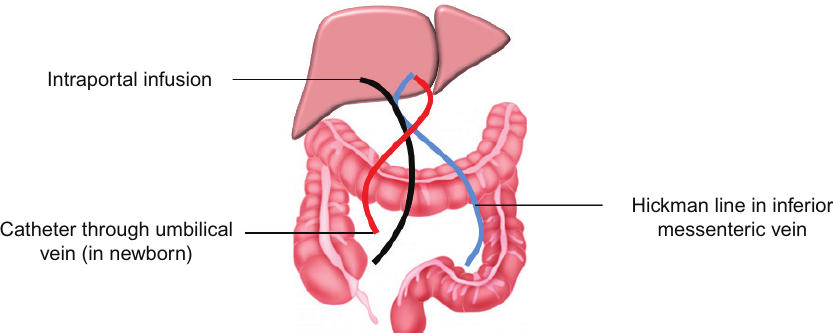
Figure 4. Liver cell transplantation routs. The portal circulation can pass directly infused cells to the liver tissue. The routine ways to directly access the portal circulation are percutaneous intraportal infusion, umbilical catheterization, and insertion of Hickman line in inferior mesenteric vein. The main concerns for transplantation of reprogrammed cells include using fresh or cryopreserved hepatocytes with cell viability of more than 60%, a minimum of 10 9 cell/infusion, and portal pressure monitoring